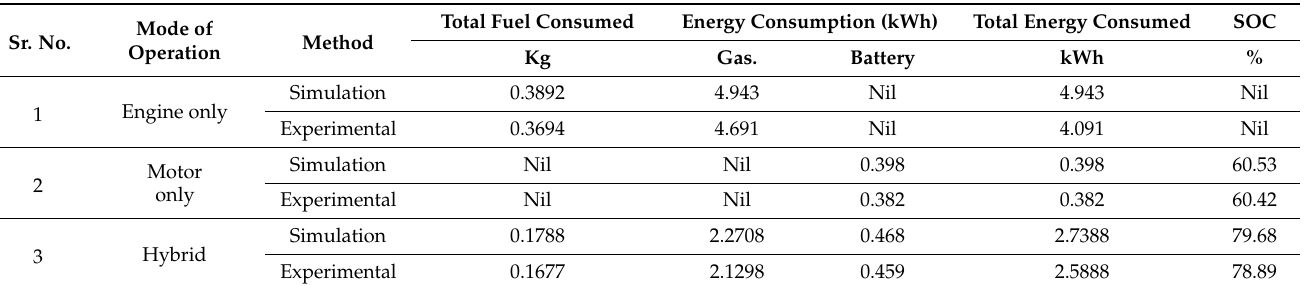
Table 4. Observations of practical and simulation results.